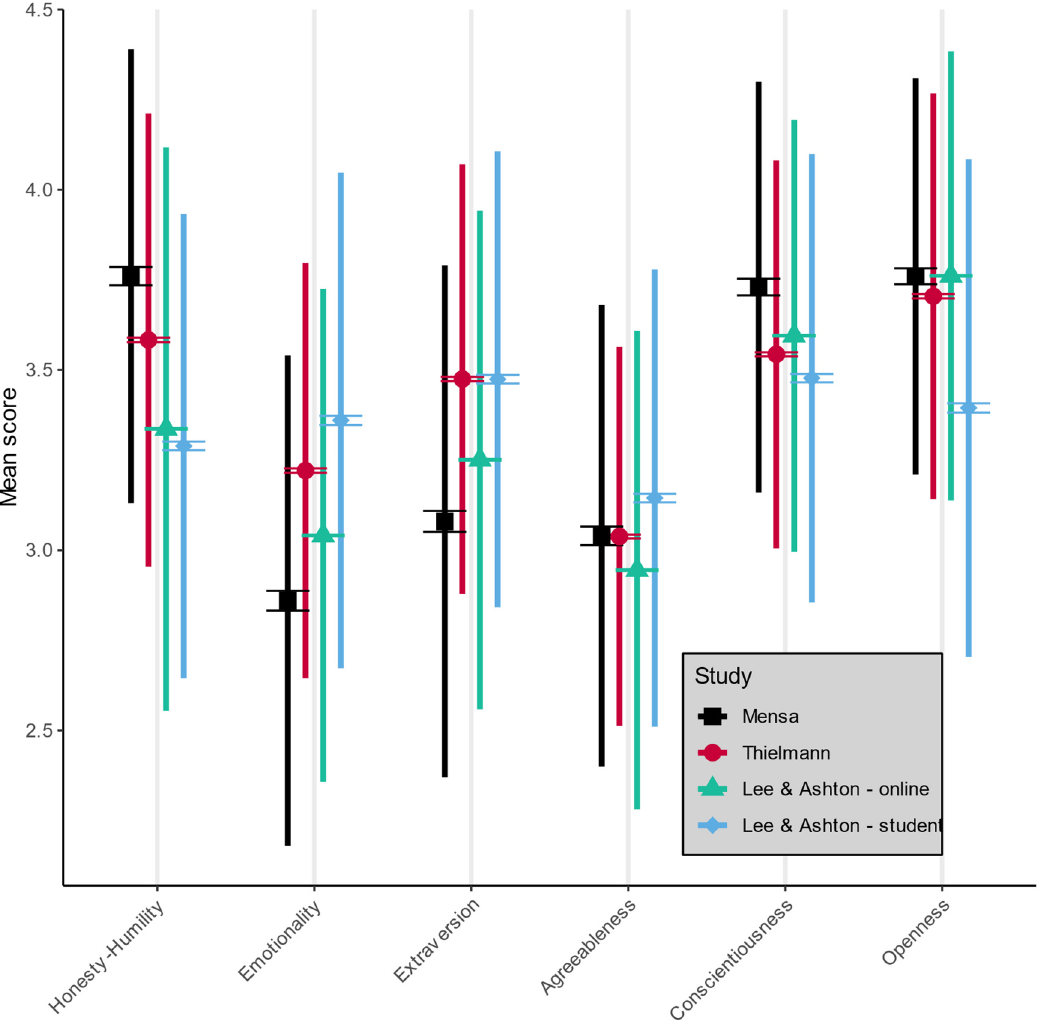
Figure 1. Means, standard errors, and standard deviations for HEXACO factors, displayed separately for the MENSA sample and reference samples. Means are indicated by symbols, standard errors are indicated by whiskers around the symbols, and standard deviations are indicated by colored bars. Table 4. Standardized mean differences (Cohen d ’s) for comparisons of HEXACO factor